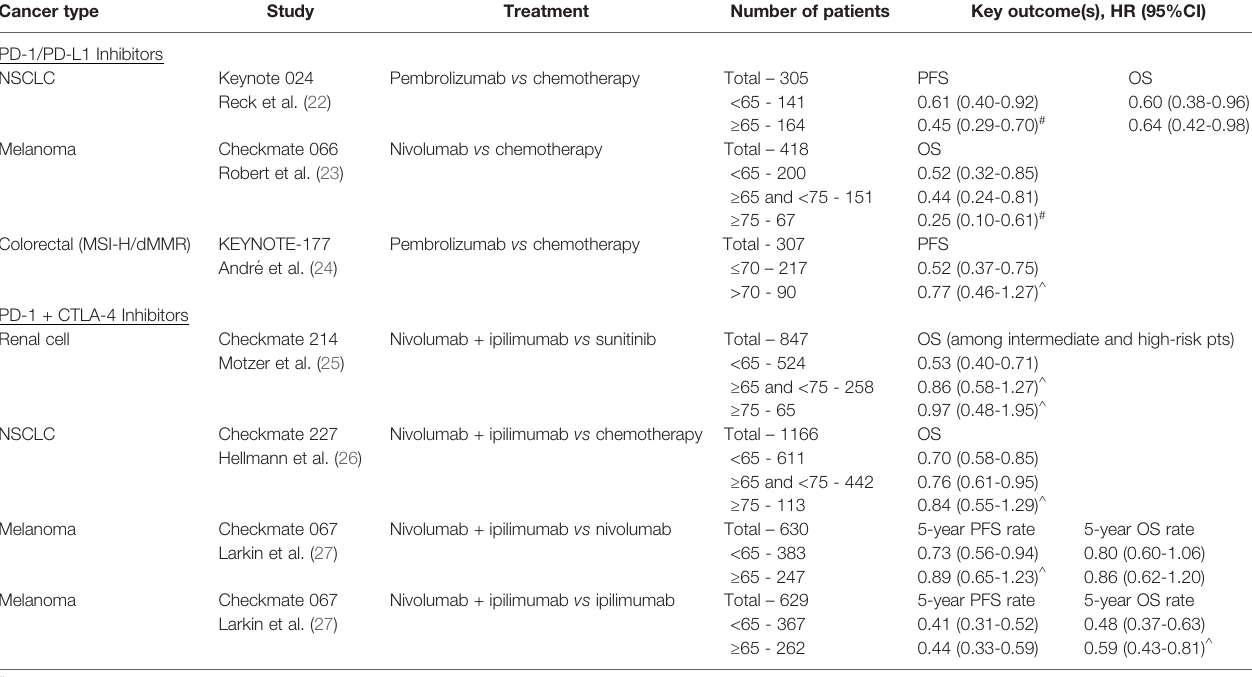
TABLE 1 | Select phase III trials of ICIs in advanced